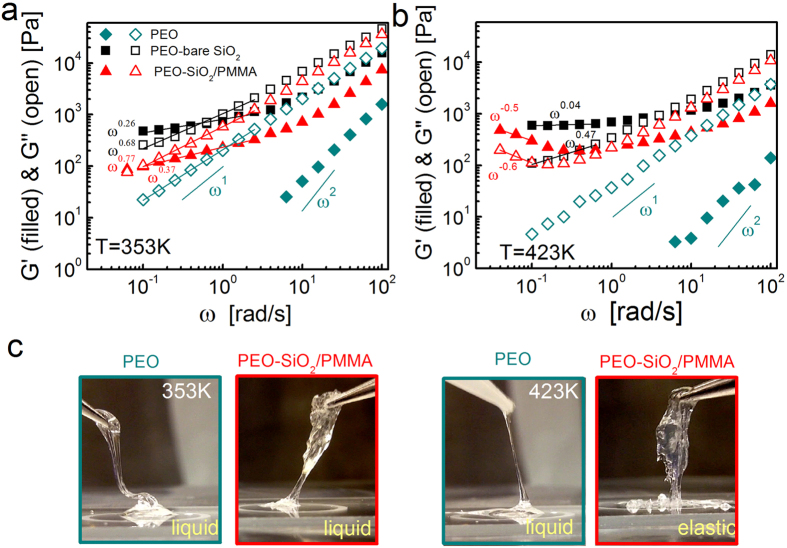
Macroscopic stiffening of PEO composite with temperature.The linear elastic (G′, open symbols) and viscous (G″, closed symbols) modulus as a function of angular frequency (ω) at 353 K (in (a) and 423 K (in (b)) for PEO melt, and nanocomposites filled with bare and PMMA-adsorbed SiO2 at 30 wt%. (c) PEO and PEO-SiO2/PMMA composite above and below Tg,PMMA. Particle-free PEO becomes less viscous while PEO-SiO2/PMMA becomes elastic at high temperature.